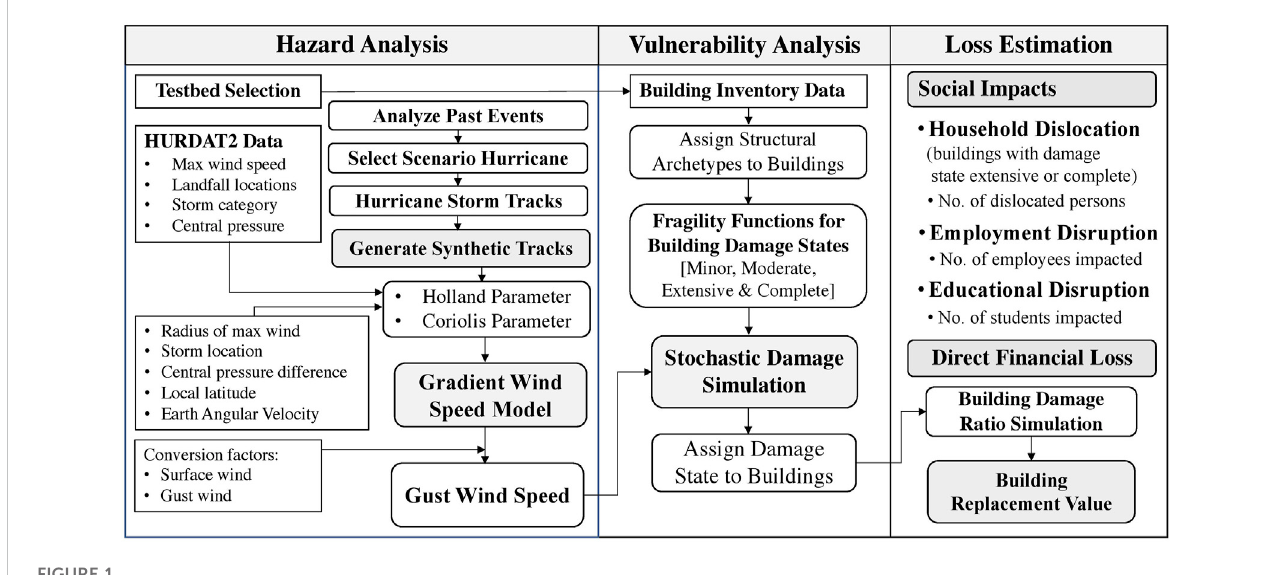
FIGURE 1 Hurricane damage and loss estimation